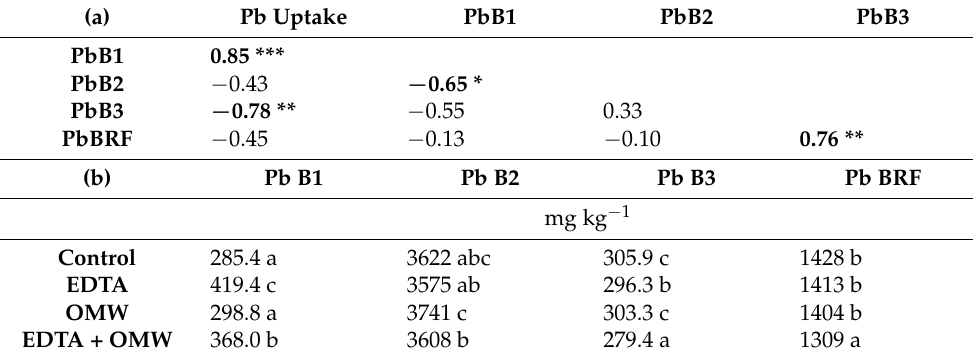
Table 5. ( a ) Pearson correlation matrix between Pb uptake by H. annuus and the respective soil fractions, as extracted by the BCR sequential extraction procedure. ( b ) Pb distribution between different soil fractions as determined by the BCR sequential extraction protocol, among different treatments. Comparisons performed by Tukey’s HSD test ( p ≤ 0.05) are demonstrated with lowercase letters and are valid within each soil fraction. The presence of a common letter implies no significant difference. *, **, *** indicate significant r values at p < 0.05, 0.01 and 0.001, respectively ( n = 3). (a) Pb Uptake PbB1 PbB2 PbB3 PbB1 0.85 *** PbB2 − 0.43 − 0.65 * PbB3 − 0.78 ** − 0.55 0.33 PbBRF − 0.45 − 0.13 − 0.10 0.76 ** (b) Pb B1 Pb B2 Pb B3 Pb BRF mg kg − 1 Control 285.4 a